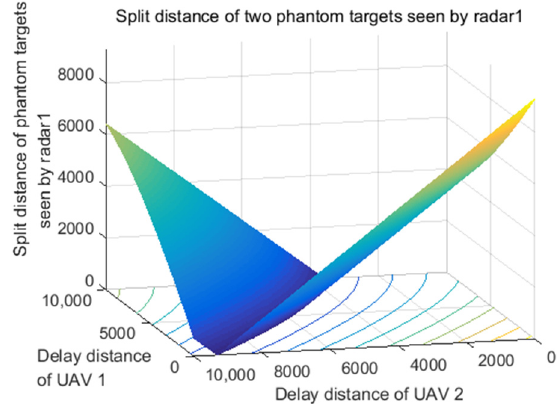
Figure 8. Split distance of two phantom targets seen by radar 1.